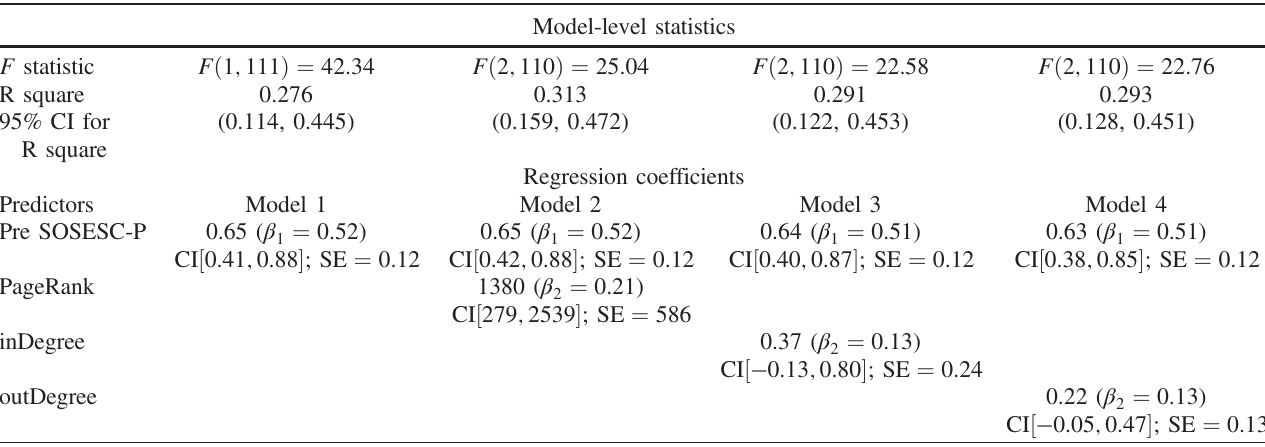
TABLE II. Models using network variables predicting post self-efficacy scores. InDegree and PageRank centralities capture a measure of recognition, but PageRank weighs that recognition according to the popularity of peers interacting with the student. Here we show that only PageRank predicts overall self-efficacy scores. Note standardized regression coefficients (i.e., β ) appear in